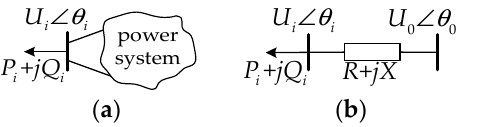
Figure 1. Partial schematic diagram of a power system. ( a ) The original system. ( b ) The equivalent system.